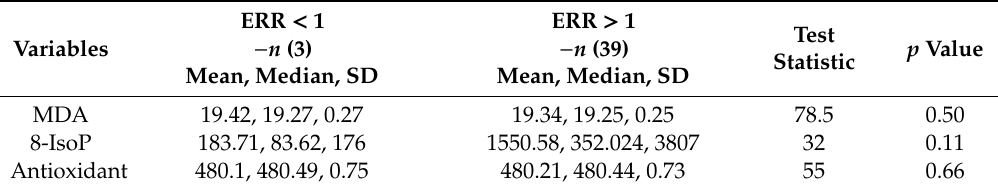
Table 4. Levels of oxidative stress biomarkers in participants with high and low ERR (Wilcoxon–Mann–Whitney